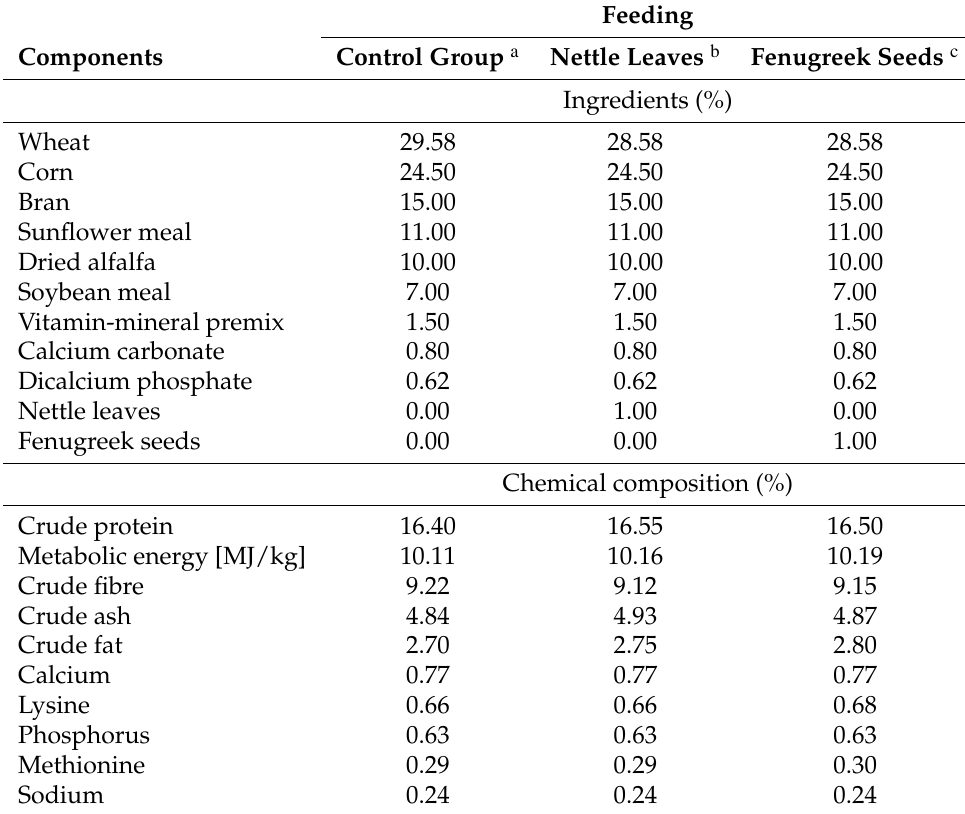
Table 1. Ingredients and chemical composition of the control and experimental feed (according to feed manufacturer FHP Barbara